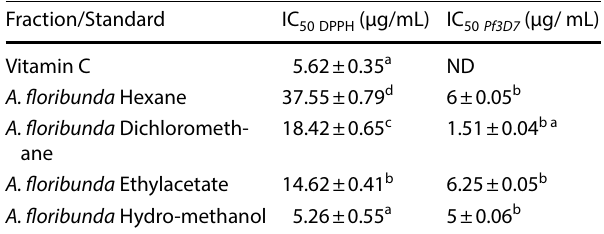
Data represent ability of extracts to inhibit DPPH’s radical and parasite growth by 50%. Values represent mean ± SEM of triplicate analyses; different lower-case letters in the same column indicates significant difference at p < 0.05; ND = Not